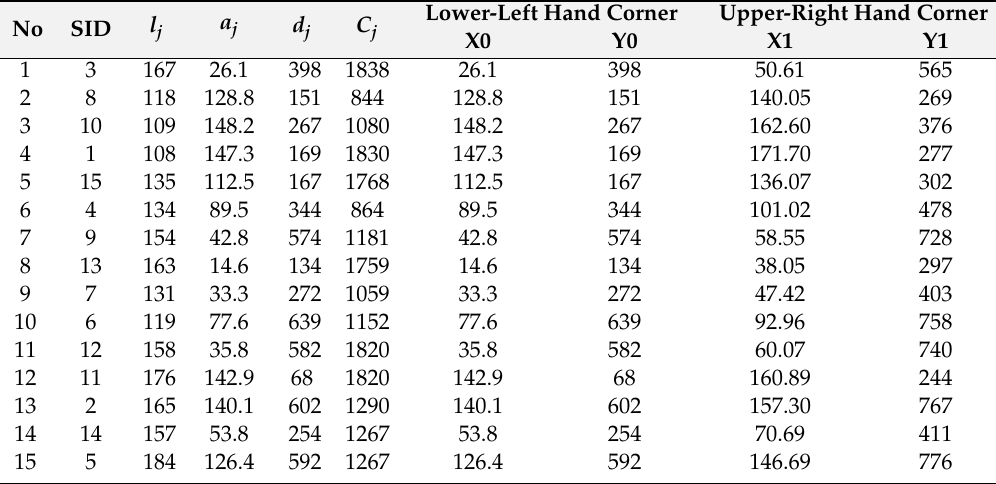
Table 2. The original data of ships ( N =